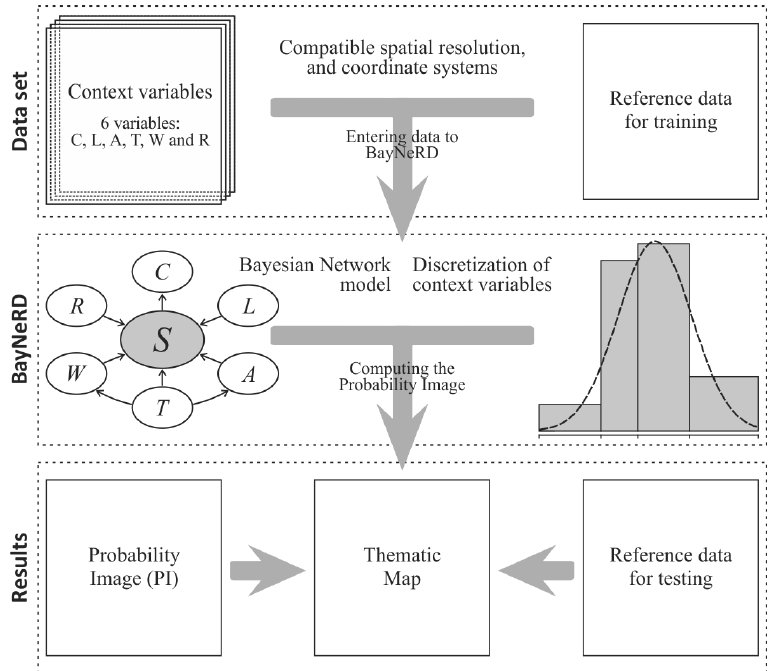
Figure 3. Summary of the procedures used in the case study of applying BayNeRD to identify soybean plantations in Mato Grosso State, Brazil. Table 1 provides a description of the variables